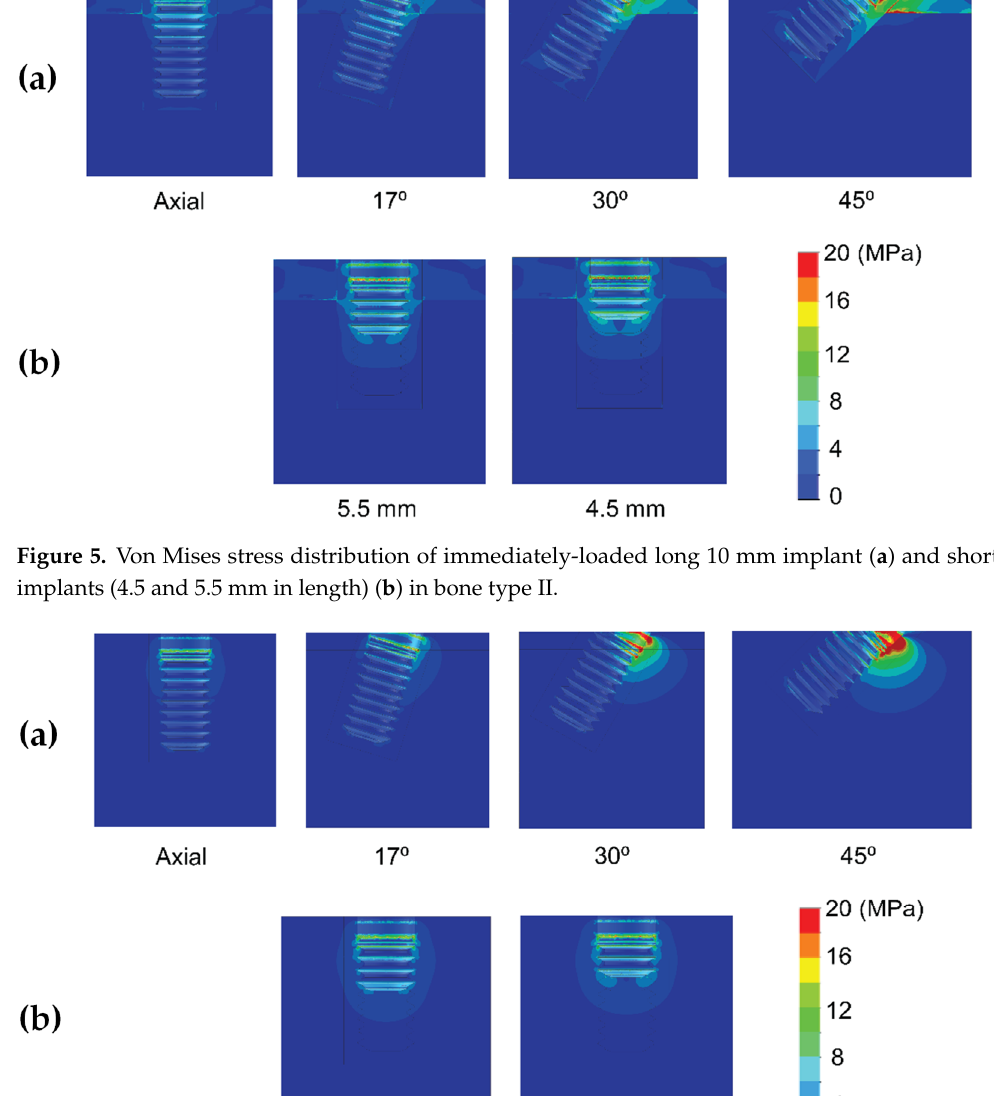
Figure 6. Von Mises stress distribution of immediately-loaded long (10 mm) implant ( a ) and short implants (4.5 and 5.5 mm in length) ( b ) in bone type 0-I.